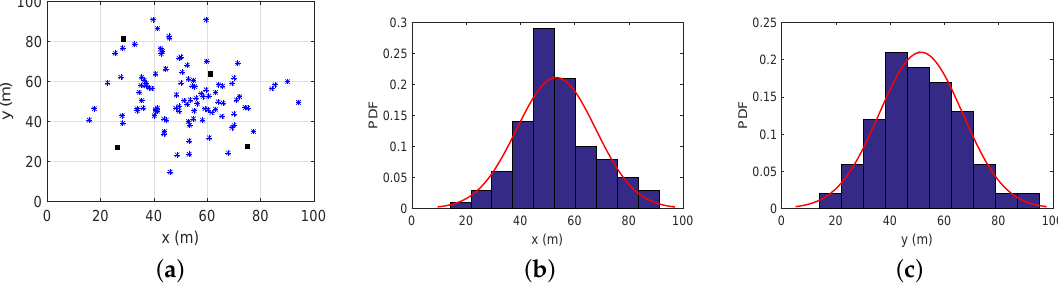
Figure 9. Estimation for 100 agent nodes’ distribution: ( a ) actual positions; ( b ) the estimation of the x -axis distribution probability; ( c ) the estimation of y -axis the distribution